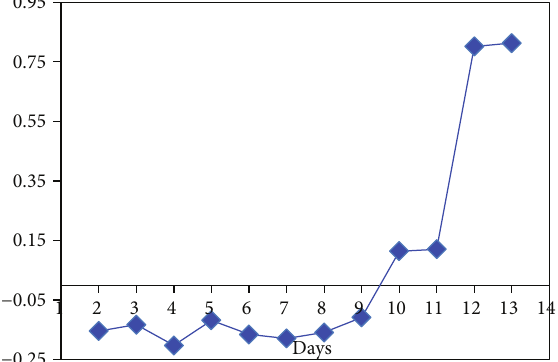
Figure 15: Skewness value during the test for all days.